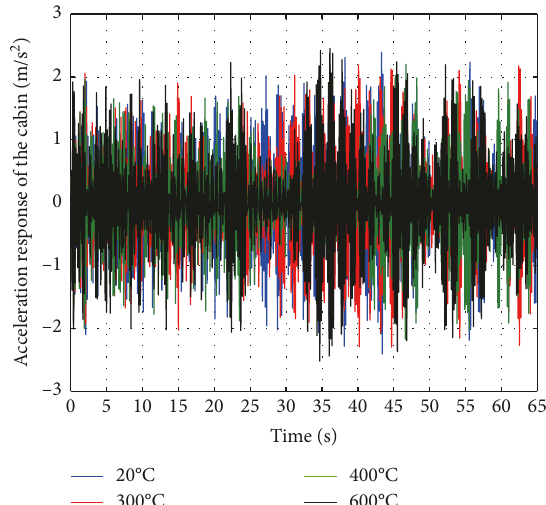
Figure 14: Acceleration response of the cabin at different